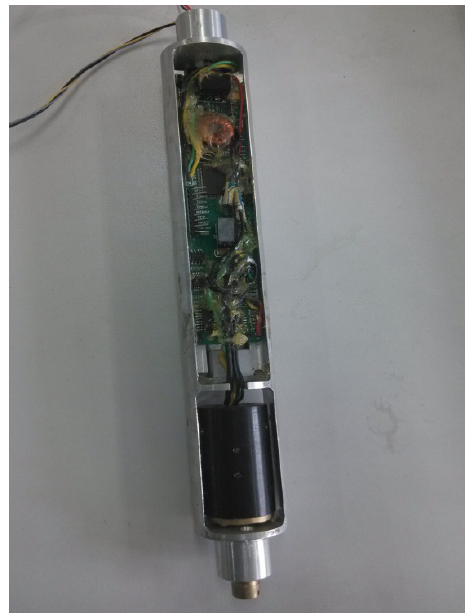
Figure 2. The measuring